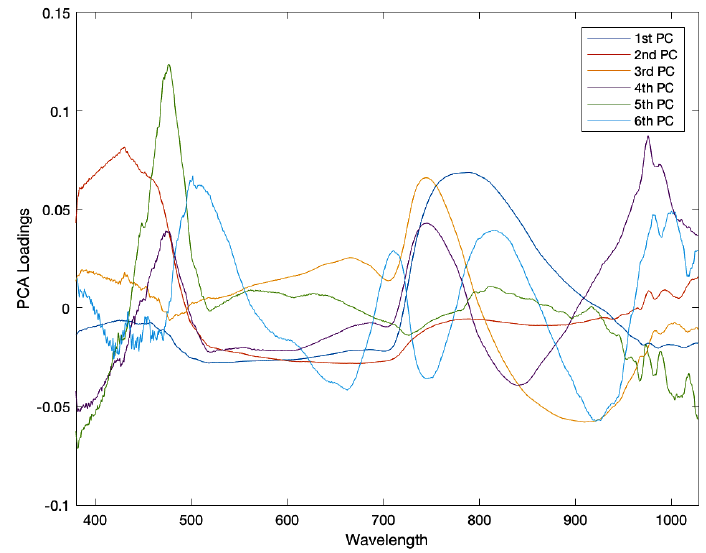
Figure 4. Loadings plot for the TF 2012 variety data matrix.